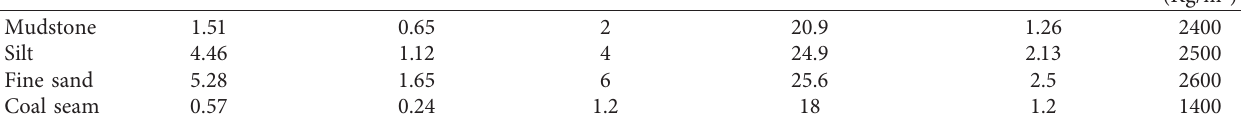
Table 1: Simulated formation physical